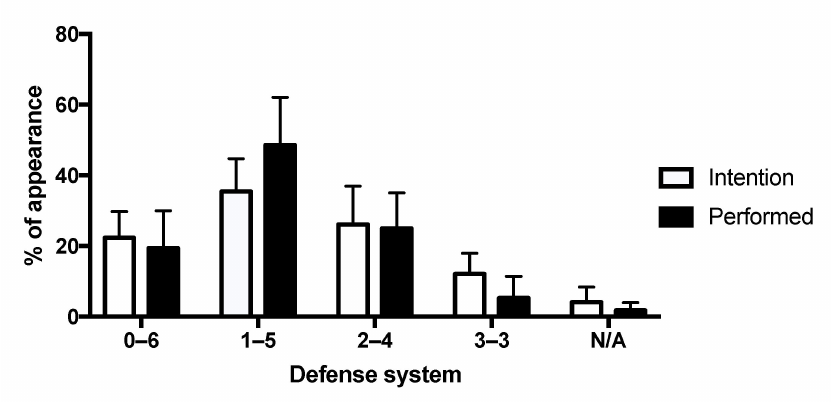
Figure 3. Mean ± SD percentage of appearance of each defensive organization (0–6, 1–5, 2–4, 3–3) for the sample of 25 matches included in the study. N/A corresponds to DEF that could not be classified into one of the four defensive organization according to our detection